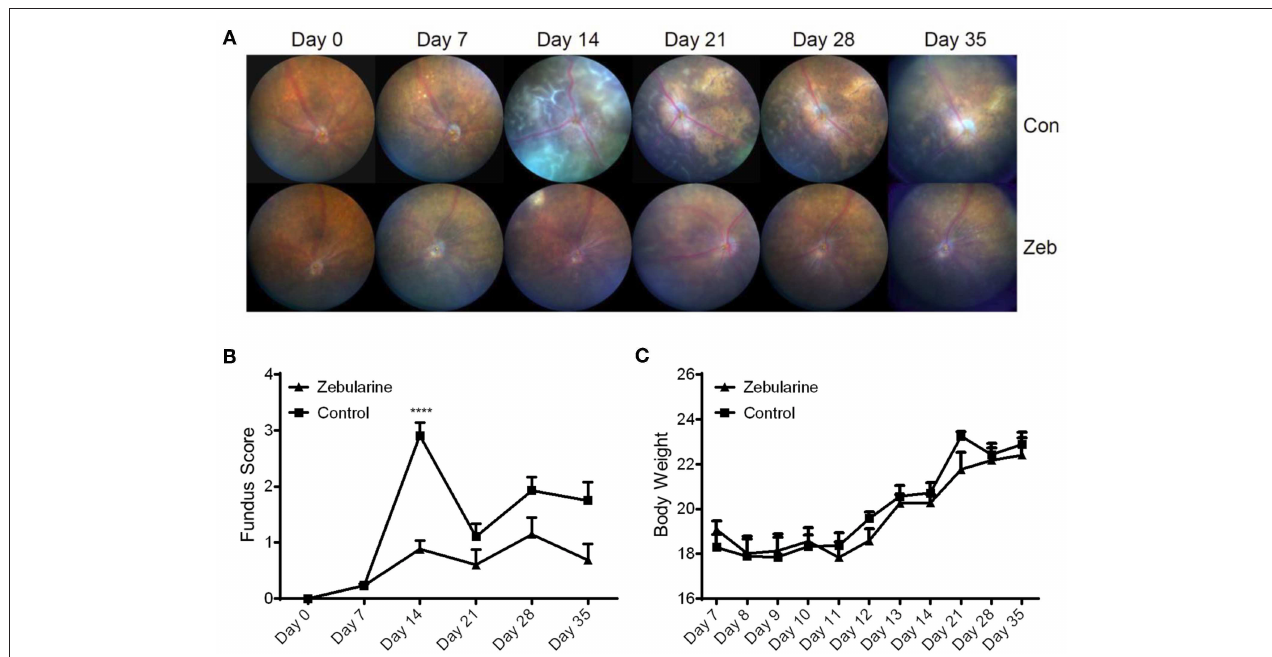
FIGURE 6 | The intraocular inflammation of EAU mice was attenuated by zebularine treatment in vivo . The representative fundus images (A) and fundus scores (B) (means ± SD) of EAU mice treated with zebularine ( N = 10) or vehicle ( N = 10) were shown **** P < 0.0001. (C) Body weights of EAU mice (means ± SD) treated with zebularine ( N = 10) or vehicle ( N = 10) were monitored every day during treatment and every week after